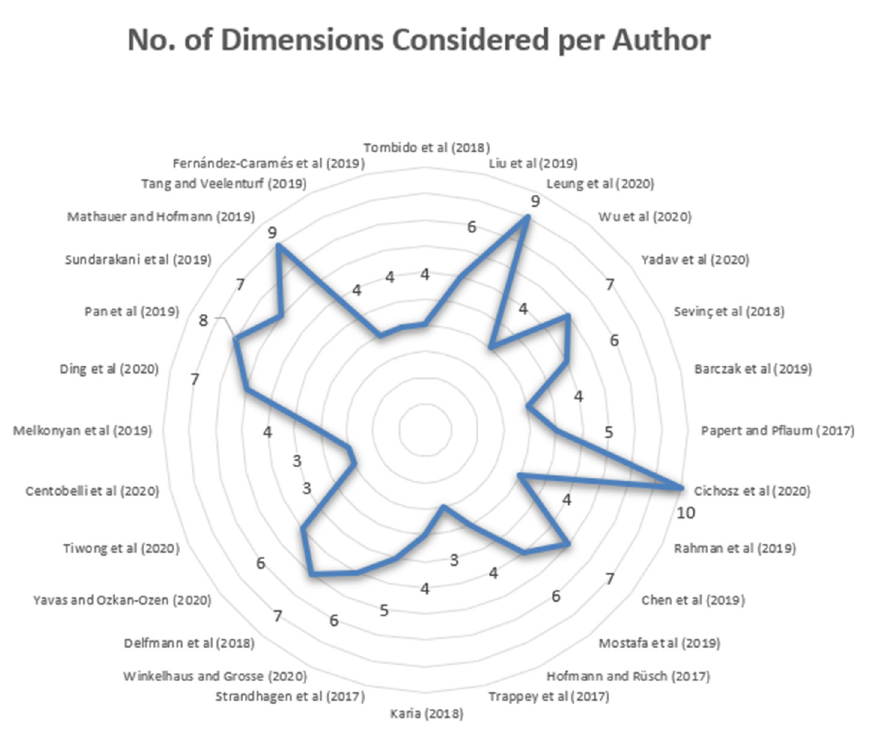
Figure 5. Number of categories per publication/author.